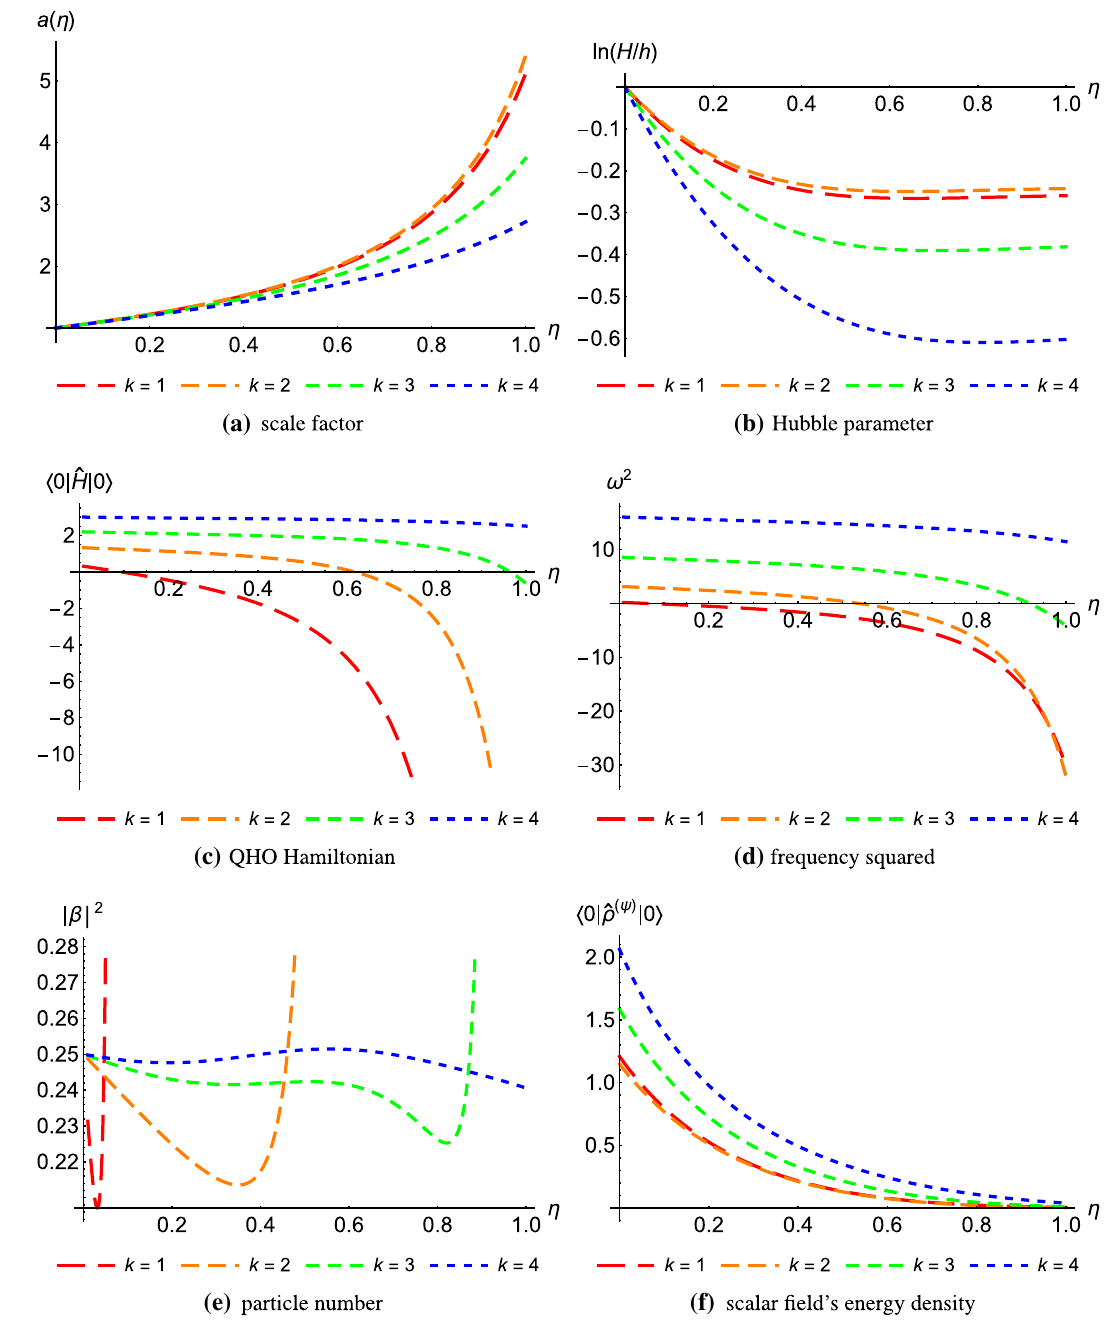
Fig. 2 Plots of a scale factor, a , b Hubble parameter, H = a (cid:8) / a 2 , c QHO Hamiltonian, (cid:4) 0 | ˆ H | 0 (cid:5) , d frequency squared, ω 2 , e particle number, | β | 2 , and f scalar field’s energy density, (cid:4) 0 | ˆ ρ (ψ) | 0 (cid:5) , obtained using the CQC for k = 1 , 2 , 3 , 4 with a 0 = 1 and h = 1